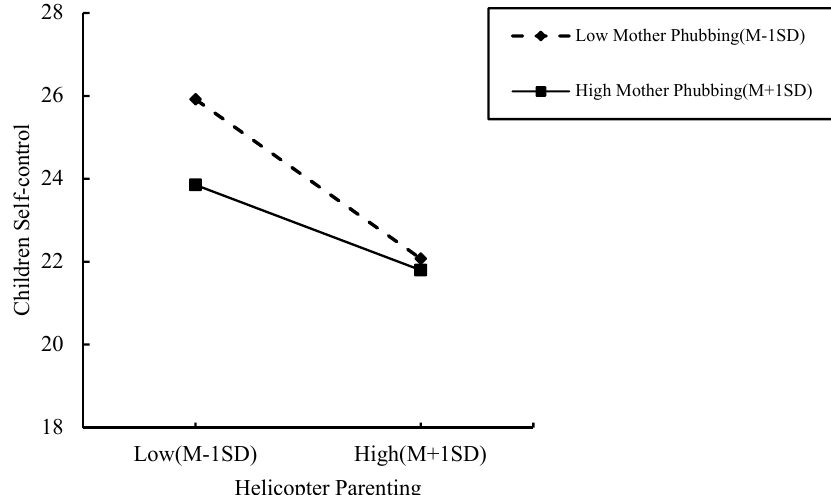
Figure 5. Moderating effects of parental smartphone use on the relationship between helicopter parenting and child self-control.